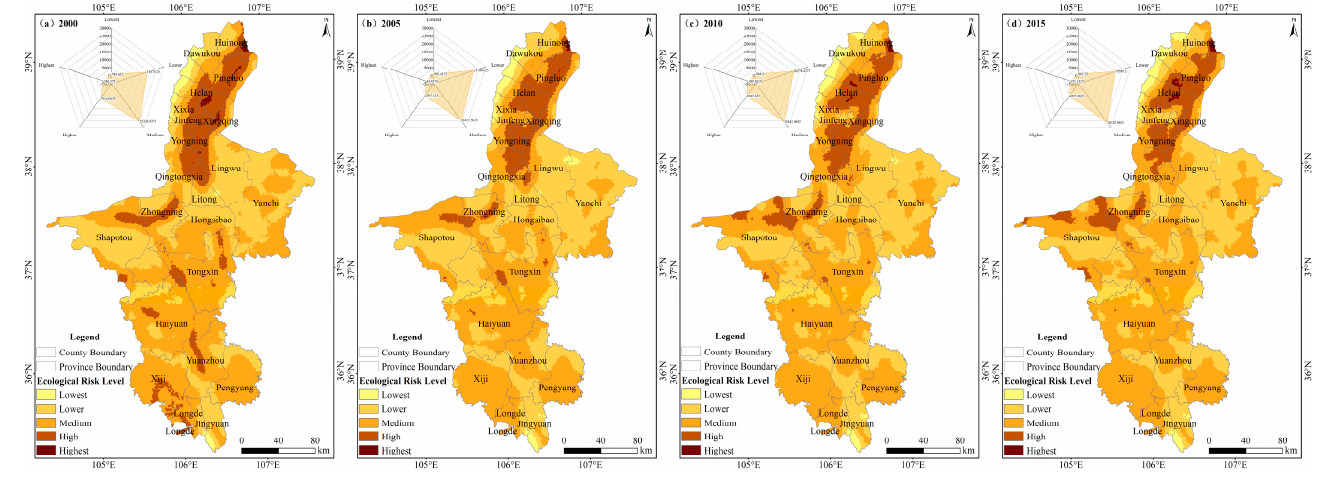
Figure 10. LER level in Ningxia from 2000 to